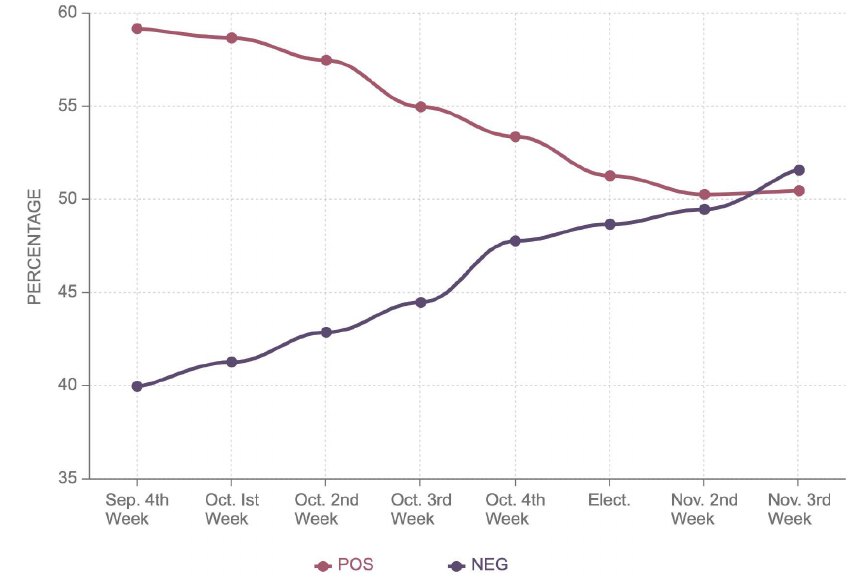
Figure 7. Graphs of positive and negative sentiments of Donald Trump in Arizona.